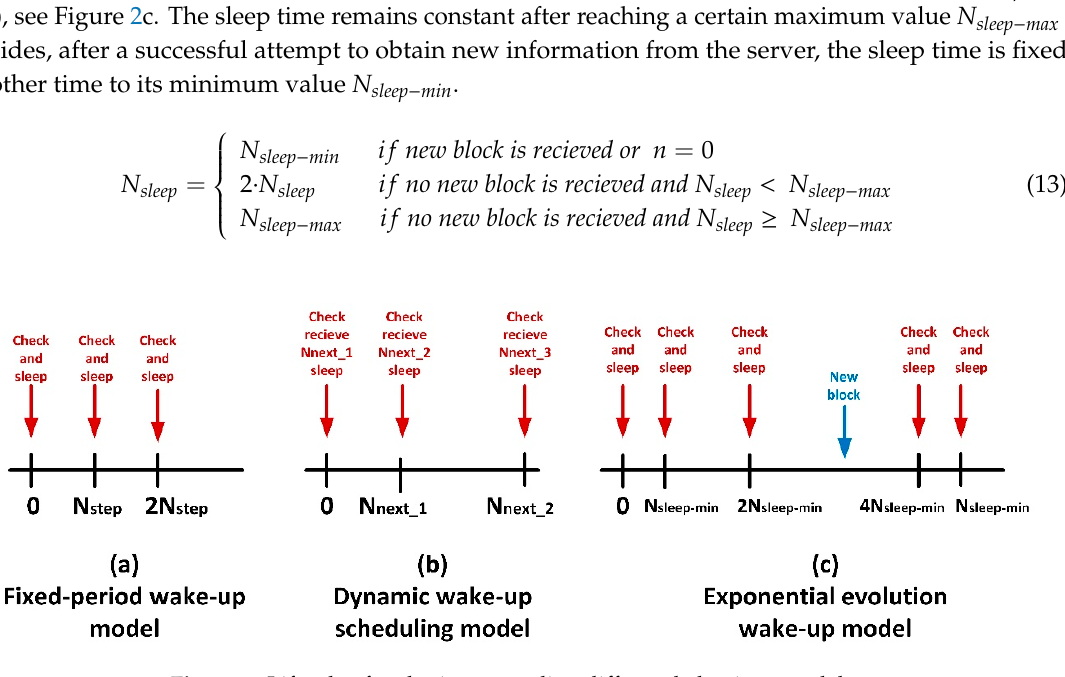
Figure 2. Lifecyle of endpoints according different behaviour models.